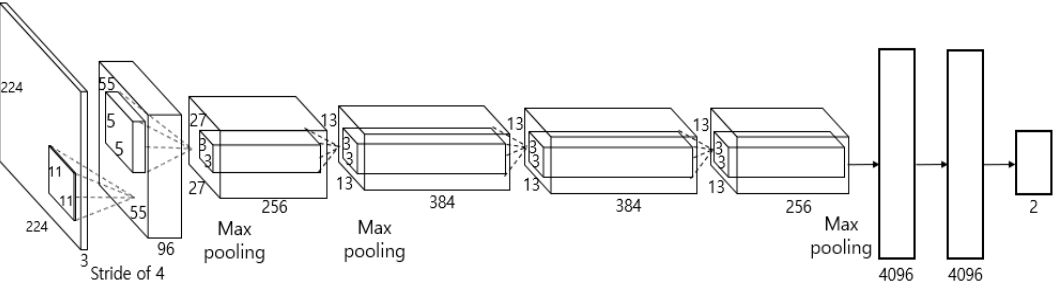
Figure 4. Structure of the shallow CNN.